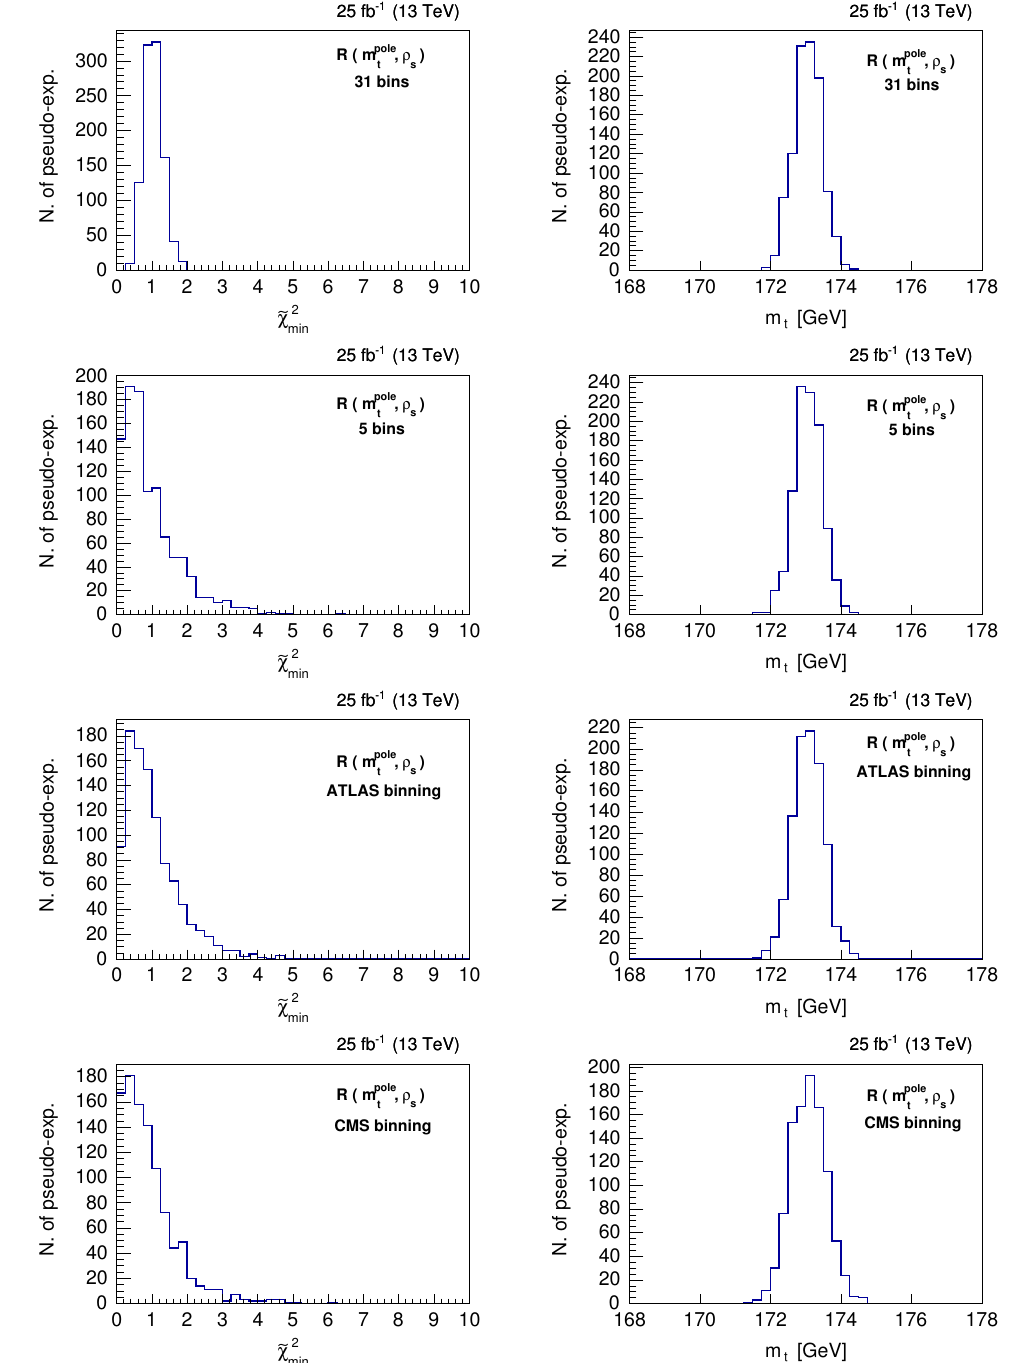
Figure 10 . Distribution of minimum ~ (cid:31) 2 ( (cid:31) 2 =d:o:f: ) and of the corresponding top quark mass (cid:17) from 1000 pseudo-experiments. Luminosity of = 25 fb (cid:0) 1 is assumed. Results are shown for full L theory for the pp e + (cid:23) e (cid:22) (cid:0) (cid:22) (cid:23) (cid:22) b (cid:22) bj + X production process at the LHC with p s = 13 TeV. The ! CT14 PDF set and (cid:22) 0 = H T = 2 are used.